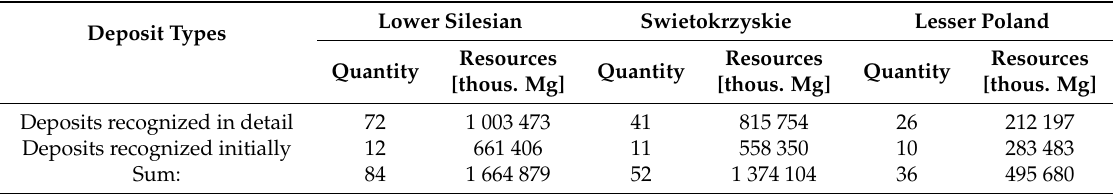
Table 3. Quantity of deposits recognized in detail and initially, along with the resources in selected provinces, status as of 31 December 2017